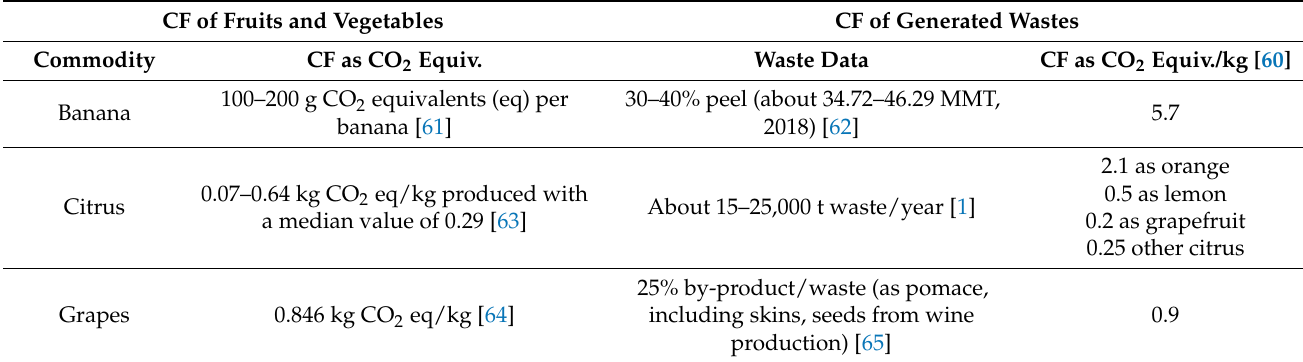
Table 1. Carbon footprint during the production and generation of wastes of some fruits and vegetables. CF of Fruits and Vegetables CF of Generated